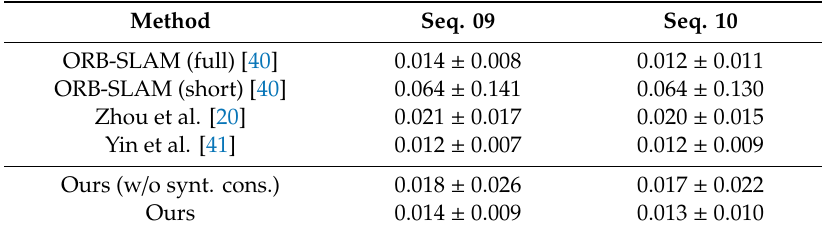
Table 3. Estimated ego-motion evaluation result. The performances are measured by computing the absolute trajectory error (ATE). The best performance is remarked in bold, and the second best is